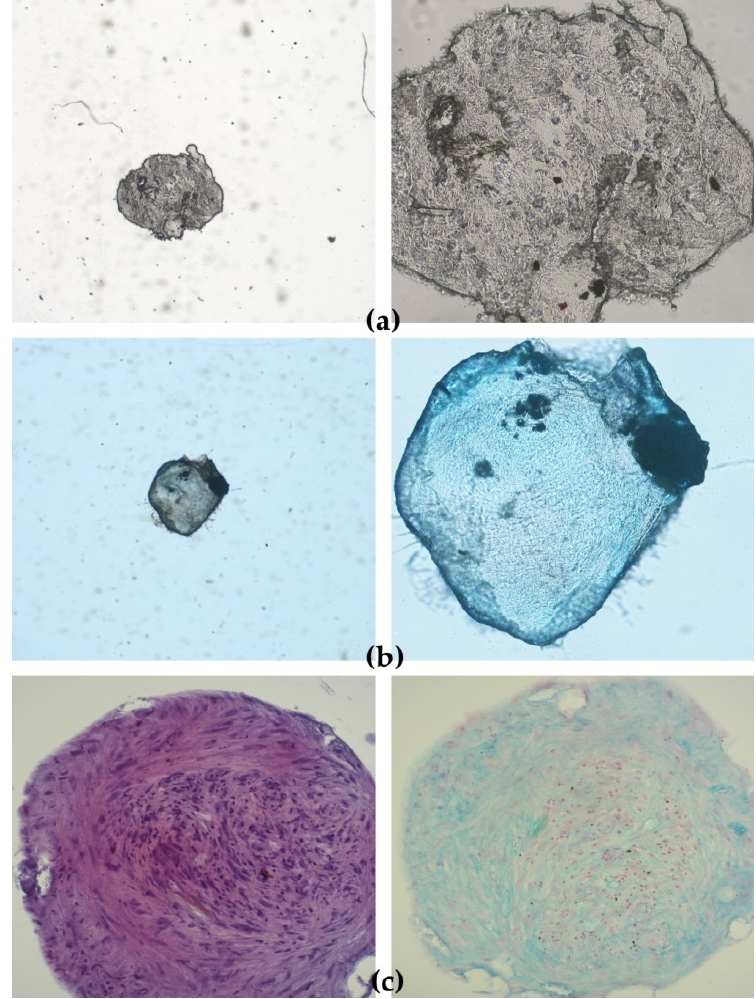
Figure 3. Functionality of canine adipose-derived mesenchymal stem cells (cAD-MSCs) demonstrated by successful chondrodifferentiation. Microscopic images of spheroids cultivated for 24 days in basal medium (negative control) stained with Alcian Blue showing lack of staining for extracellular matrix (ECM) aggrecan, 5× and 20× ( a ). Spheroids cultivated for 24 days in StemMACS ChondroDiff Media, stained with Alcian Blue, showing staining for ECM aggrecan, 5× and 20× ( b ). Images of histological sections of paraffin-embedded spheroids stained with hematoxylin-eosin (H&E) and Alcian Blue 20× ( c ).